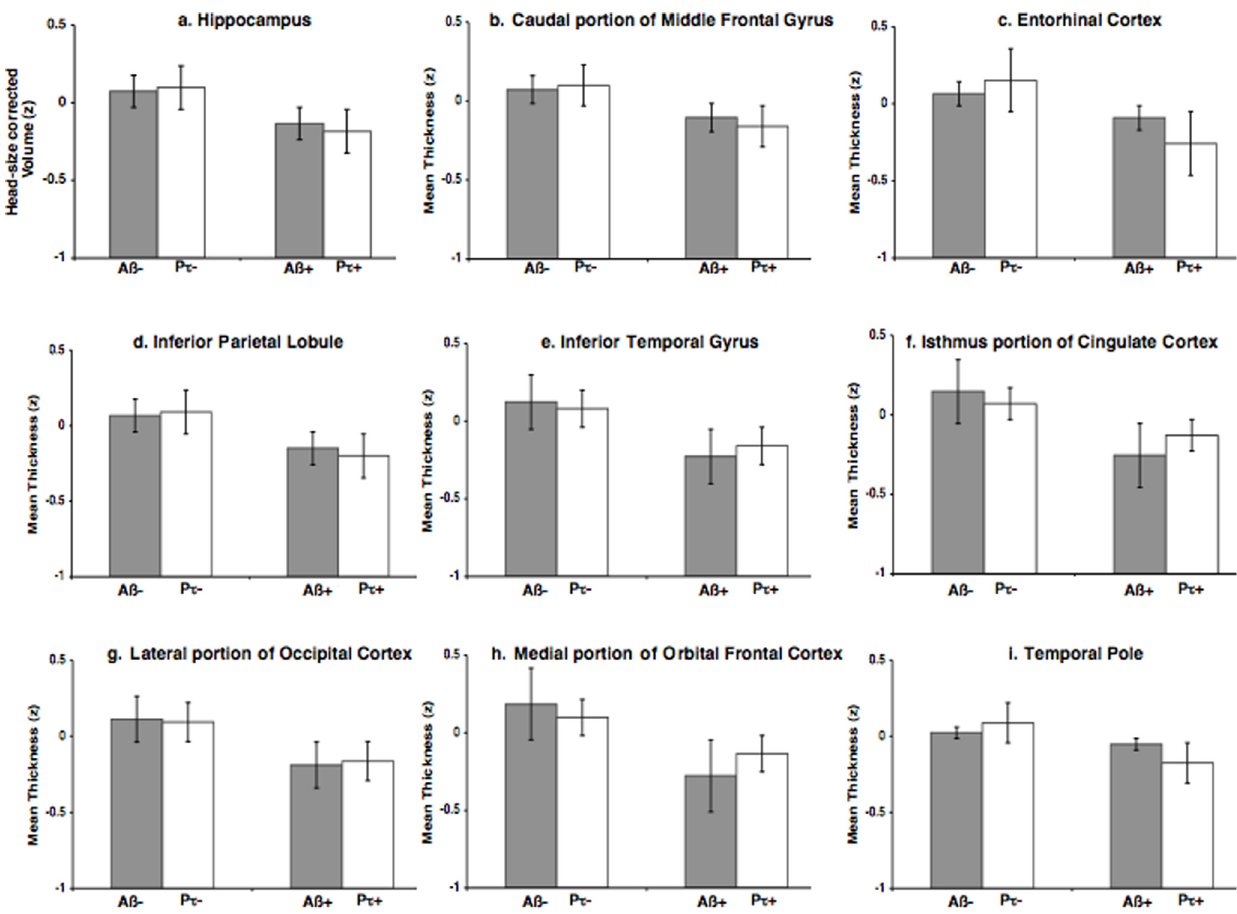
Figure 3. Bar plots illustrating mean cortical thickness, standardized to Z scores, for the 8 neocortical ROIs amongst the amyloid positive (A b + ), amyloid negative (A b 2 ), p-tau positive (P t + ), and p-tau negative (P t 2 ) older individuals. Error bars indicate 1 standard error of the mean.